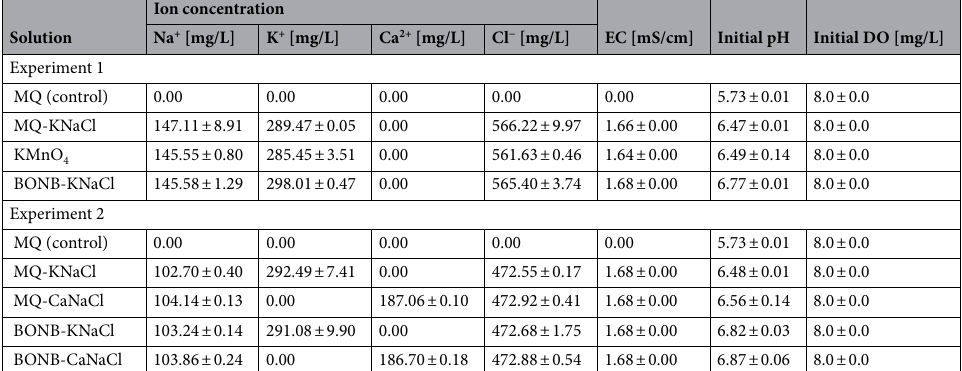
Table 1. Properties of culture media used in the experiments. EC was measured at 15 °C. Values are presented as mean ± SE. EC electrical conductivity, DO dissolved oxygen, MQ Milli-Q water, MQ-KNaCl Milli-Q water containing K + , Na + , and Cl − , BONB-KNaCl bulk oxygen nanobubble water containing K + , Na + , and Cl − , MQ-CaNaCl Milli-Q water containing Ca 2+ , Na + , and Cl − , BONB-CaNaCl bulk oxygen nanobubble water containing Ca 2+ , Na + , and Cl −